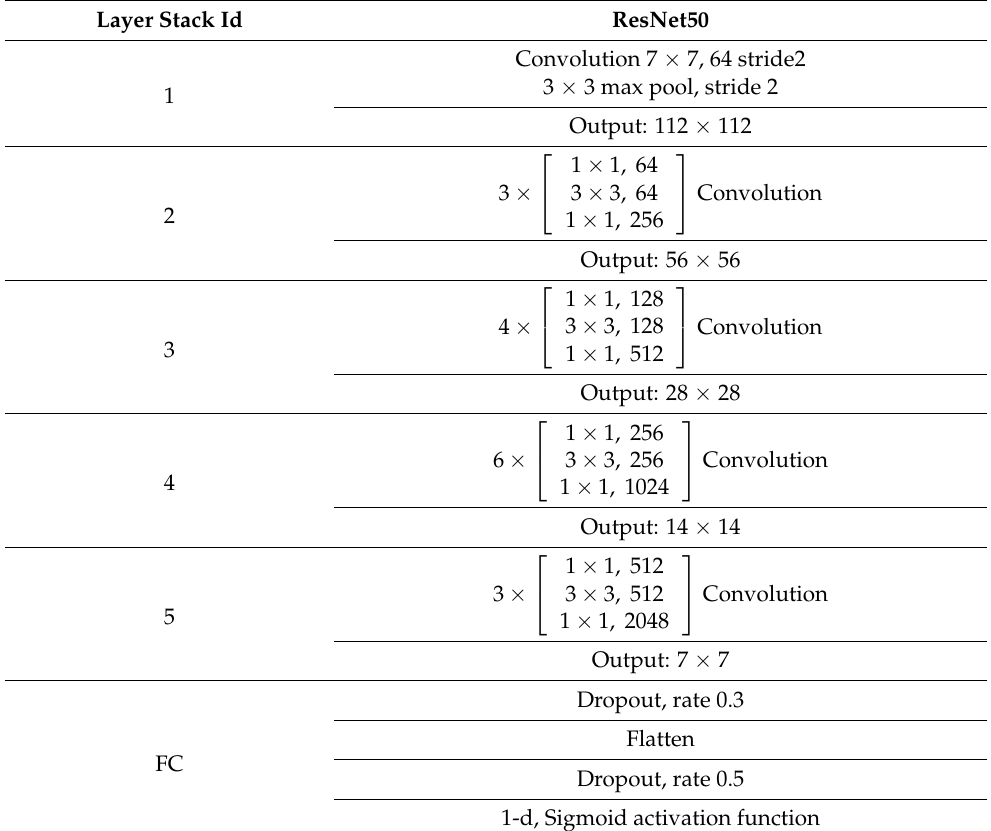
Table 2. ResNet50 architecture of the proposed method, adapted from K. He et al.